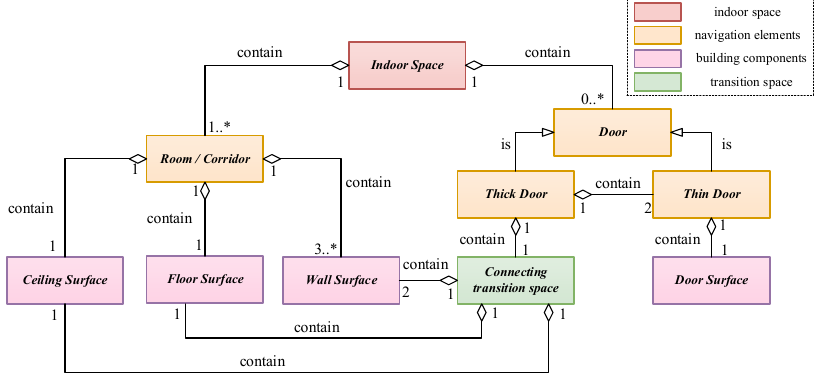
Figure 1. Hierarchy of indoor space navigation elements and building components.